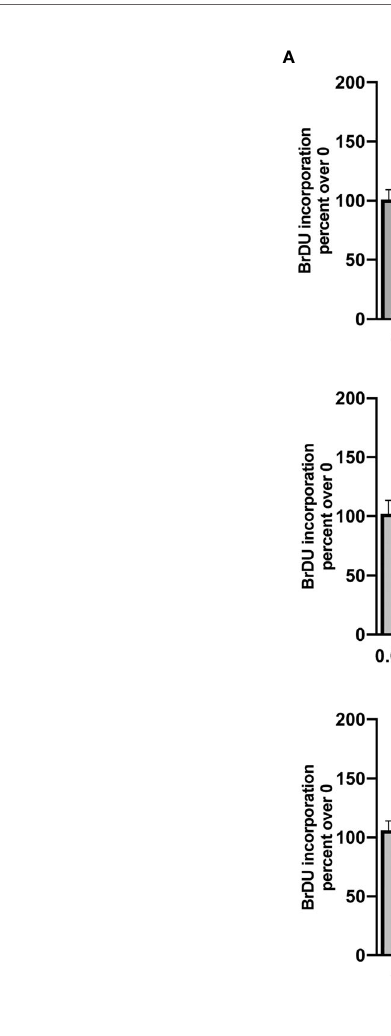
FIGURE 1 | (A) Chronic exposure of human thyrospheres (aggregates of stem/precursor thyroid cells) to heavy metals at the indicated salt concentrations signi fi cantly increased BrdU incorporation in all cases. Basal values in untreated cells were always considered equal 100 and values of BrdU incorporation after cell exposure to metals were expressed as percent changes over basal. The dose-response curves followed in all cases a biphasic pattern, declining after the peak value when metal concentrations were further increased. Data shown for each metal indicate the average values ± SEM of four separate experiments except for W (ten separate experiments). In differentiated thyrocytes none of the fi ve heavy metals studied or their mixture had any effect on BrdU incorporation. *p < 0.05, **p < 0.01 and ***p < 0.001 vs. 0. (B) The mixture of the fi ve metals studied (Mix), each at the concentration causing the maximum BrdU incorporation, promoted